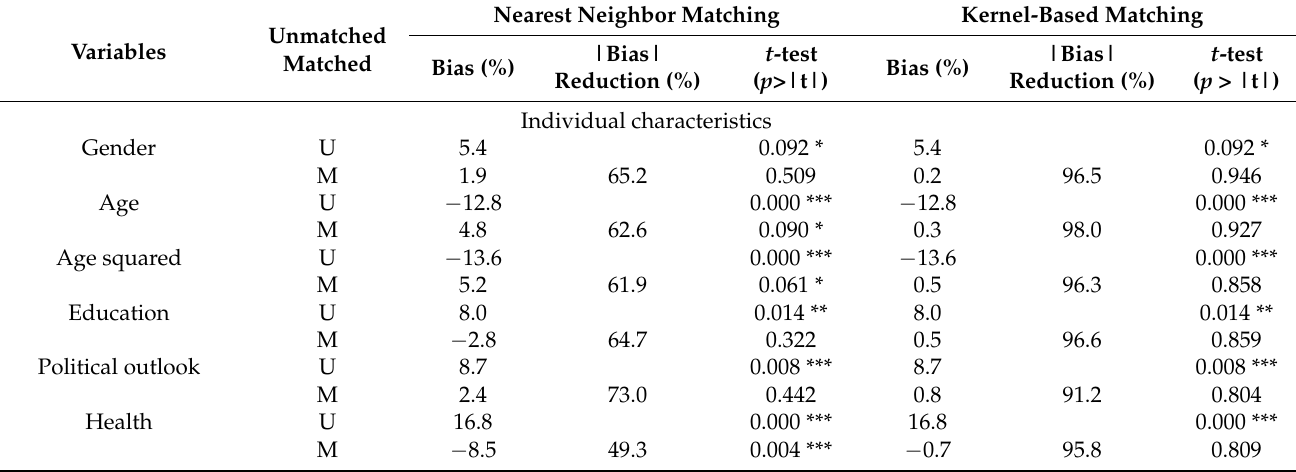
Table 4. PSM quality indicators before and after